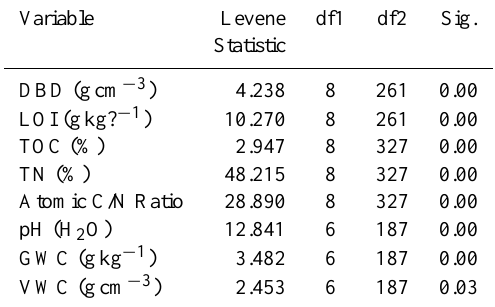
Table 13. Test of Homogeneity of Variances. Table 14. Robust Tests of Equality of Means of DBD, LOI, TOC, TN, Atomic C/N Ratio, pH, GWC and